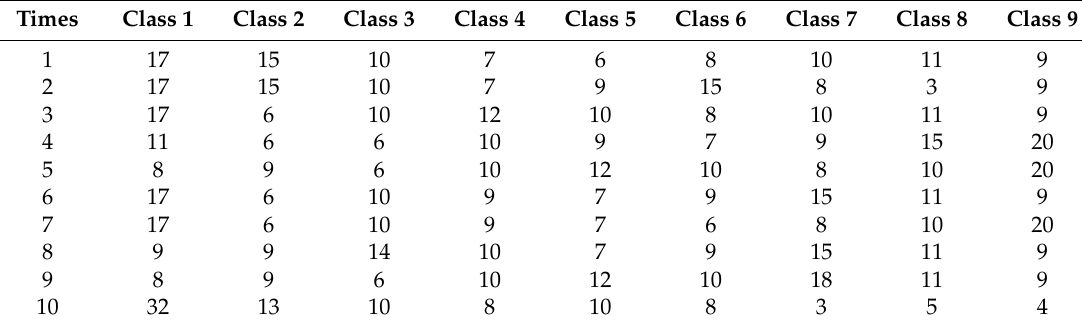
Figure 7. Classification results of K-means. Table 1. The statistics for the number of class members in the result of K-means clustering (10 times). Times